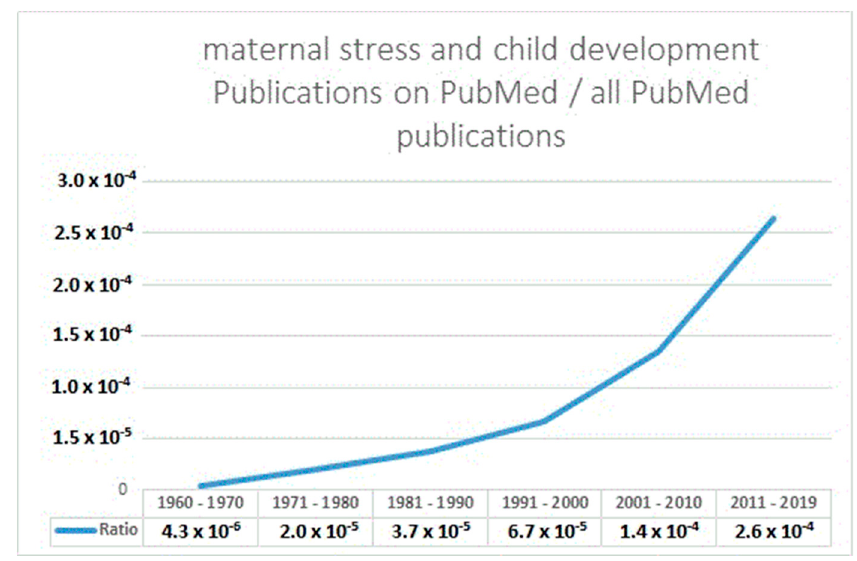
Figure 1. The relative portion of articles deposited on PubMed on maternal stress and child Figure1. development.